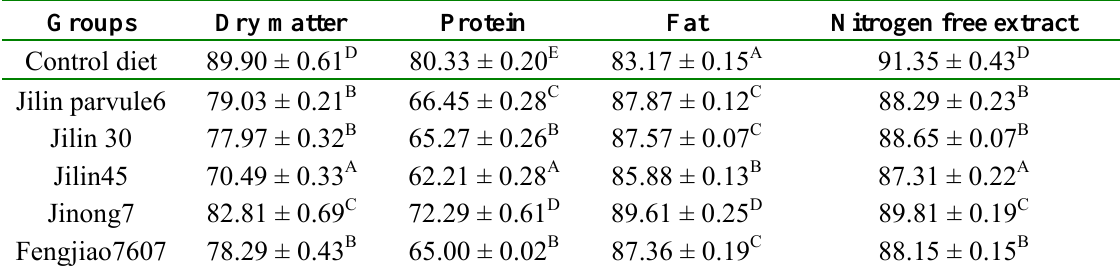
Table 4. Main nutrient digestibility of diet (%)